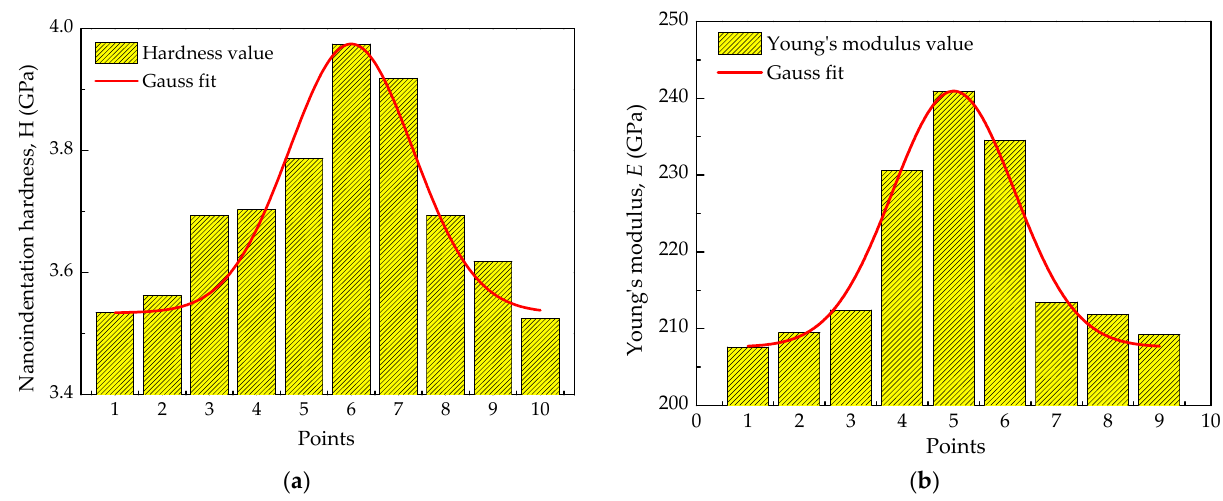
Figure 2. Micromechanical properties of the weld center area of the weld joint. ( a ) Nanoindentation hardness; ( b ) Young’s modulus. Table 1. Mechanical properties of Alloy 600 in Pressurized Water Reactor environment (340 °C ).